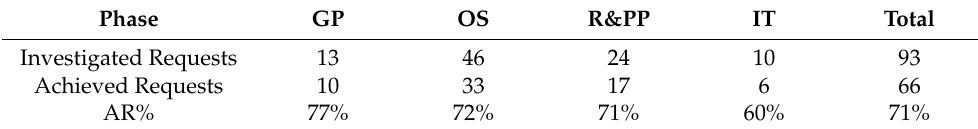
Figure 7. The Topology Optimization results respectively from TS-A, TS-B, TS-C and TS-D. Table 4. Summary table for a generic TS.